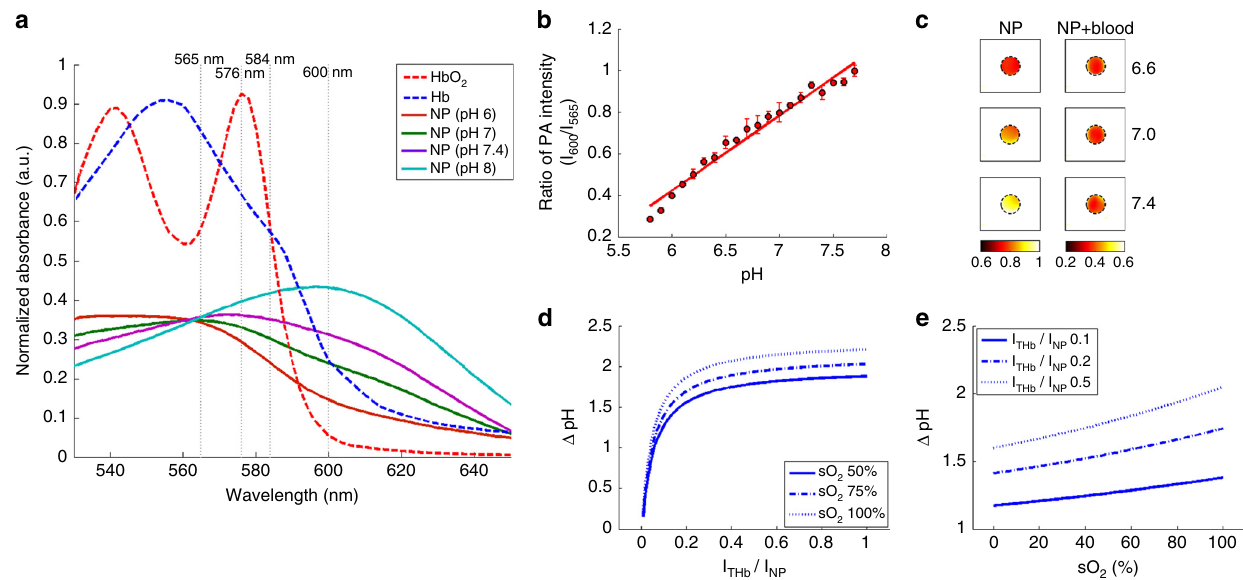
Fig. 3 Limitation of dual-wavelength ratiometric photoacoustic imaging of pH. a Spectroscopic optical absorption of oxygenated hemoglobin (HbO 2 ), deoxygenated hemoglobin (Hb) and SNARF-PAA NPs at different pH levels. b Measured PA signal amplitude ratios between the two wavelengths (600 nm/565 nm) as a function of pH (pH 5.8 – 7.8 with 0.1 pH interval) ( n = 3, error bars represent standard deviations). By performing a linear fi tting of the scattered measurements in the range of pH 5.8 – 7.8, a calibration line was generated. c The PA ratiometric images (600 nm/565 nm) of phantoms containing SNARF-PAA NPs buffered at pH 6.6, 7.0 and 7.4, respectively. The nanoparticle (NP) images are for phantoms with NPs and the NP + blood images are for phantoms with NPs containing blood (1% w/w). The color scale represents the ratio between the PA intensities at the two wavelengths (600 nm/565 nm). d Estimated errors (i.e., Δ pH) in dual-wavelength ratiometric PA pH measurement as a function of the ratio between the PA signal amplitudes from total hemoglobin (THb) and SNARF-PAA NPs (i.e., I THb /I NP ). The three curves are for three different hemoglobin oxygen saturation (sO 2 ) levels (50, 75 and 100%). e Estimated errors (i.e., Δ pH) in dual-wavelength ratiometric PA pH measurement as a function of the blood sO 2. The three curves are for three different ratios of I THb /I NP (0.1, 0.2 and